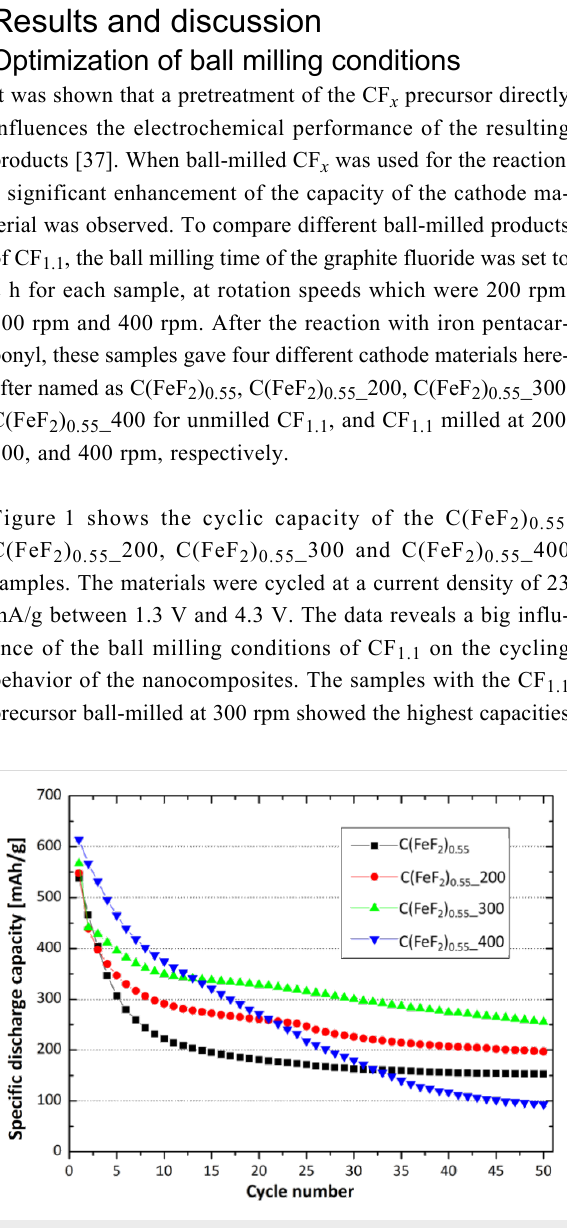
Figure 1: Cycling behavior of C(FeF 2 ) 0.55 , C(FeF 2 ) 0.55 _200, C(FeF 2 ) 0.55 _300 and C(FeF 2 ) 0.55 _400. The materials were cycled with a current density of 23 mA/g between 1.3 V and 4.3